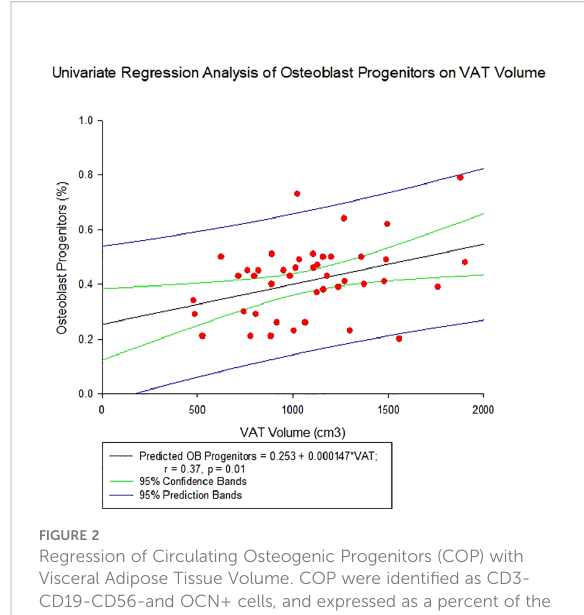
FIGURE 2 Regression of Circulating Osteogenic Progenitors (COP) with Visceral Adipose Tissue Volume. COP were identi fi ed as CD3- CD19-CD56-and OCN+ cells, and expressed as a percent of the nucleated, viable population.